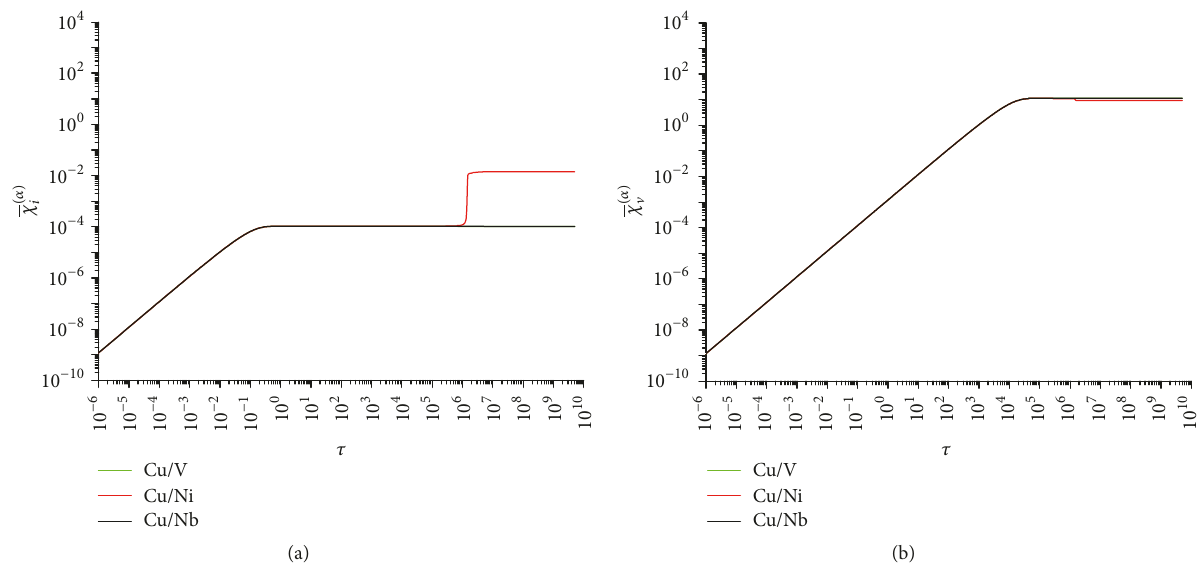
Figure 2: Temporal profiles of average (a) SIA and (b) vacancy concentration in layer 𝛼 .